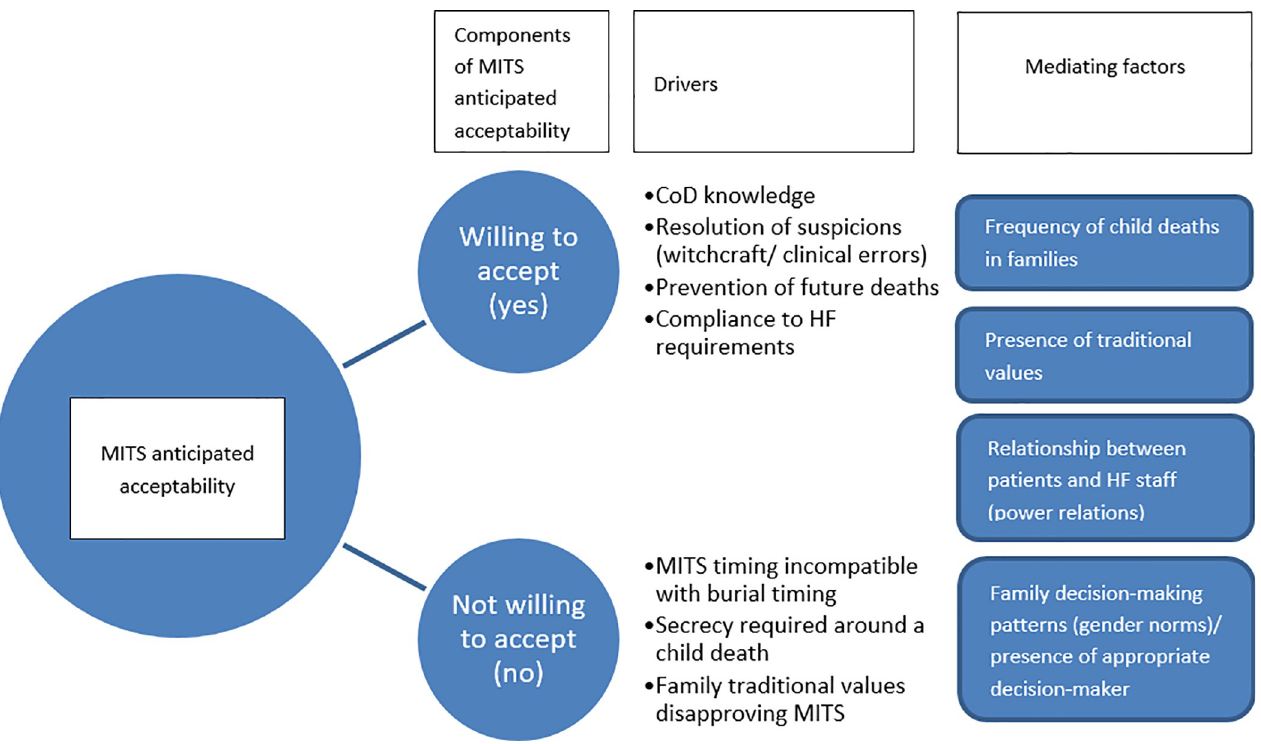
Fig 2. Dimensions of anticipated acceptance of MITS. Components, drivers and mediating factors explaining MITS acceptance among relatives of deceased children before the implementation of MITS.